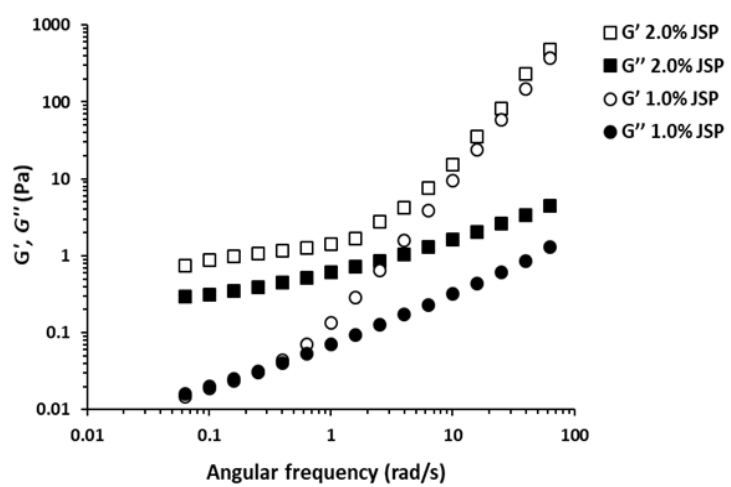
Figure 8. Storage modulus ( G’ ) and loss modulus ( G’’ ) vs. angular frequency (rad/s) for JSP aqueous solutions for different concentrations (1.0%–2.0%, w/v ) at 25 °C in water.